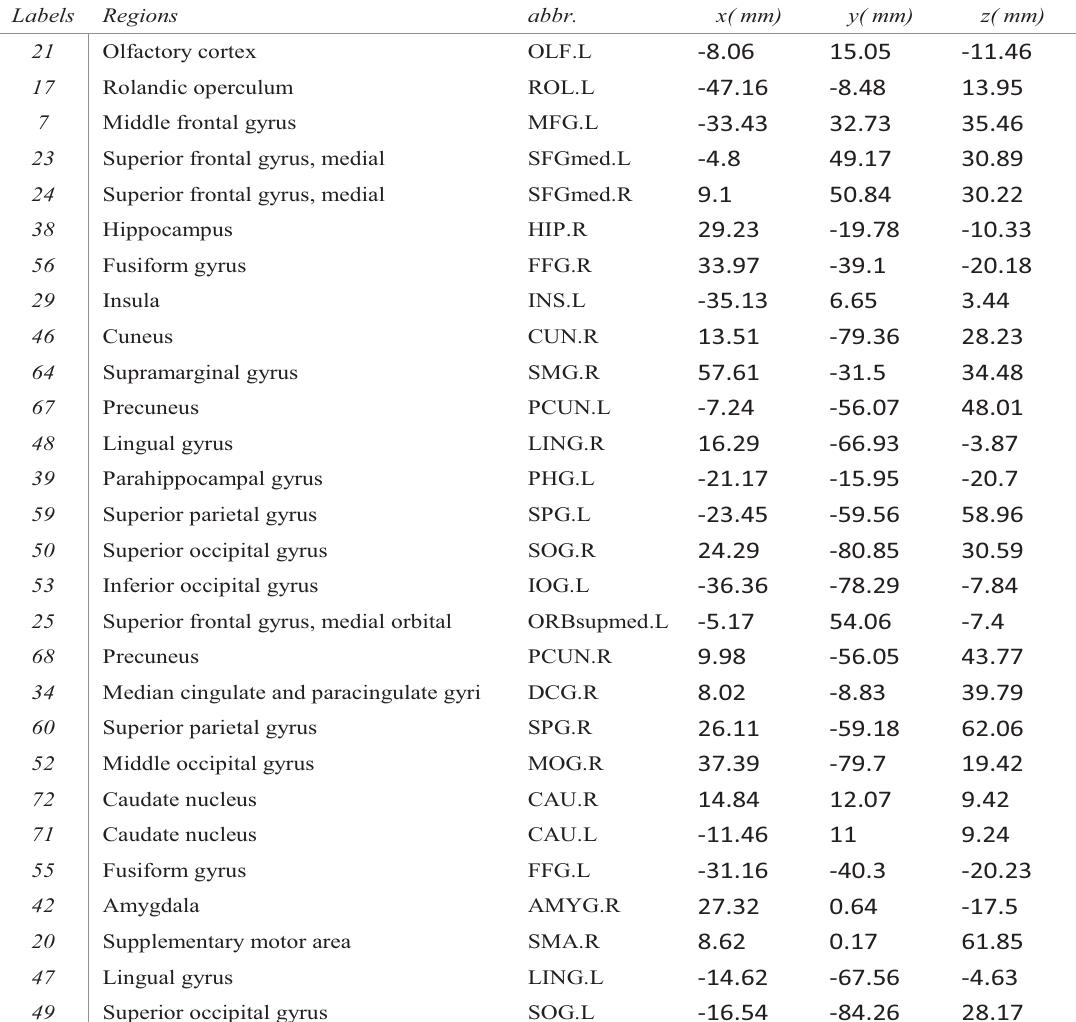
Figure A2. Twenty eight brain regions selected for the experiment according to the AAL